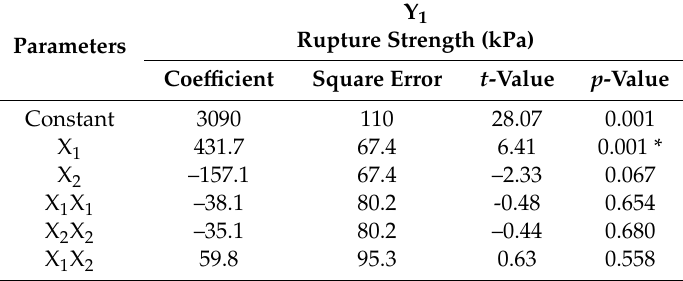
Table 5. Estimated coe ffi cients of the fitted quadratic polynomial equations for dependent variables based on the t